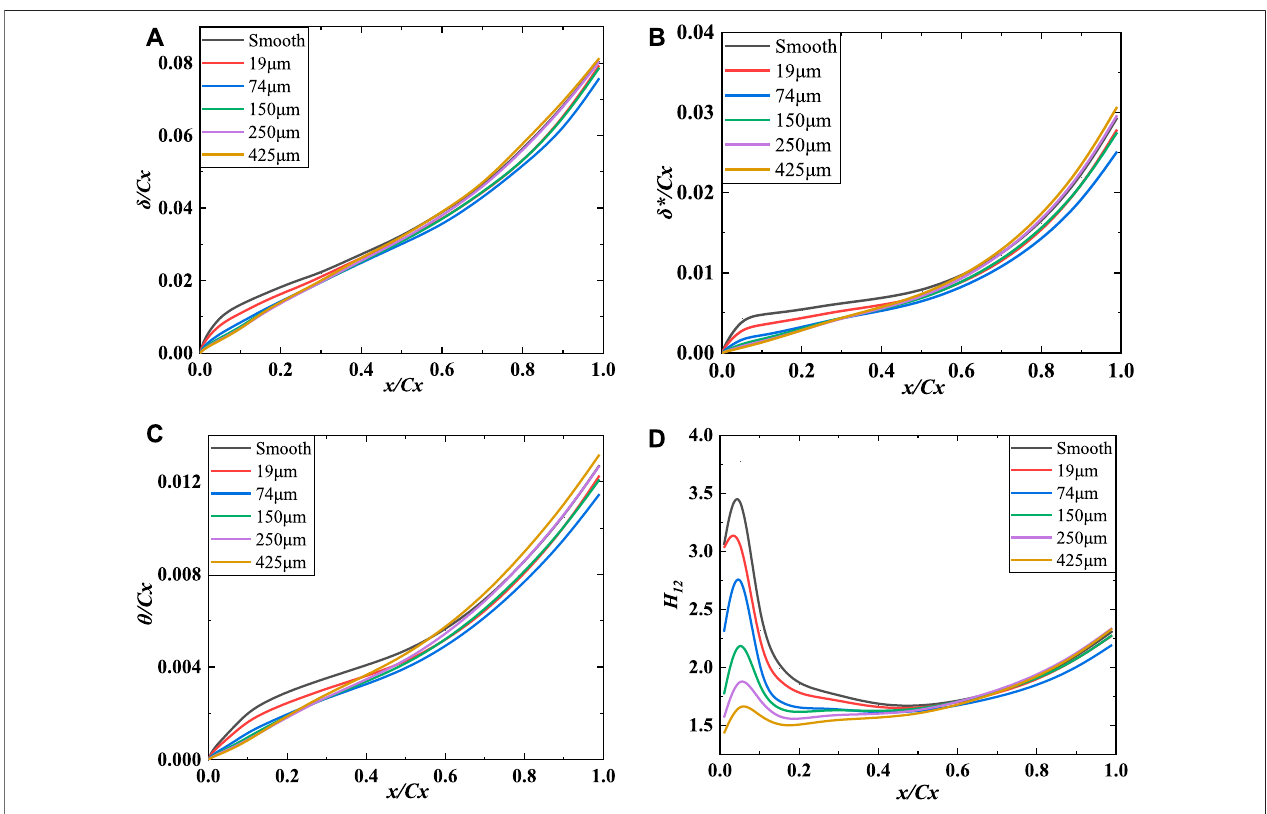
FIGURE 14 | In fl uence of roughness on the boundary layer parameters of the suction surface: (A) boundary layer thickness, (B) displacement thickness, (C) momentum thickness, and (D) shape factor.